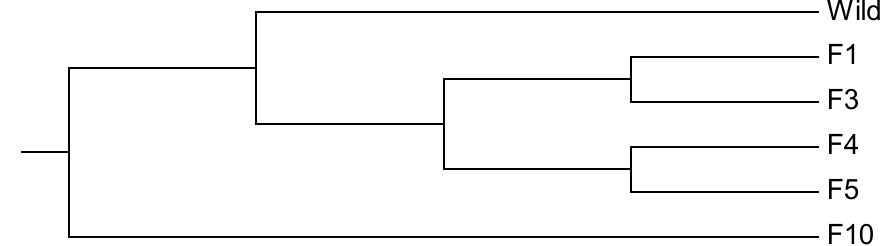
Figure 3. Phylogenetic tree of six groups constructed using the UPGMA clustering method based on Nei’s genetic distances (Table 4) for the 20 SNPs loci.